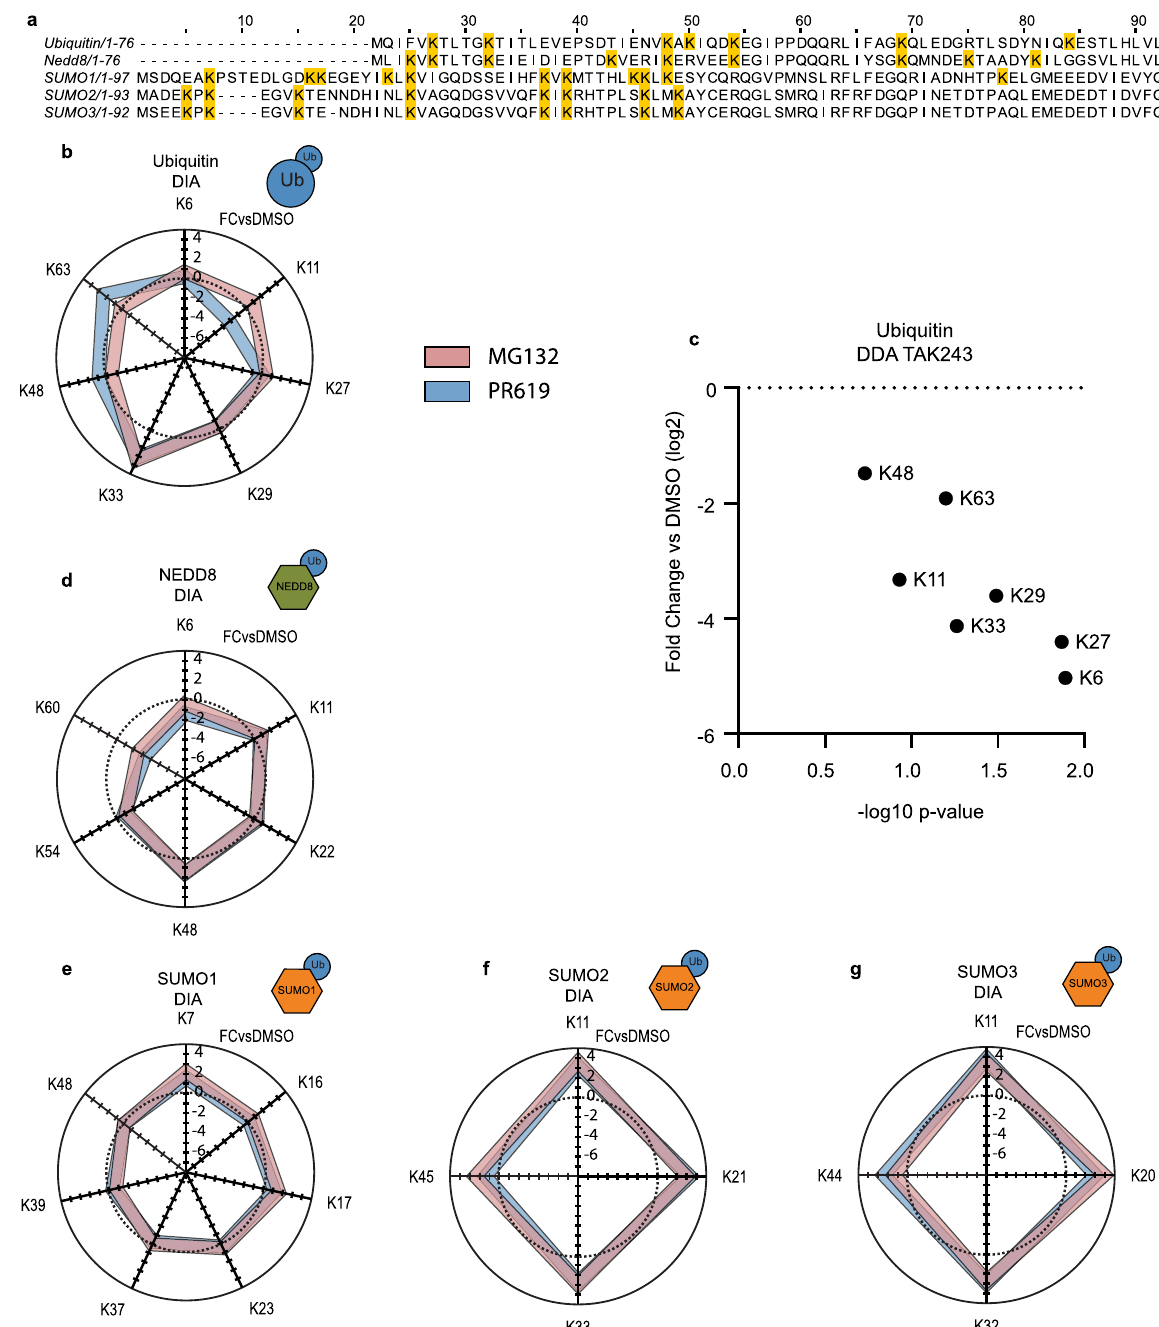
Fig. 6 Signalling dynamics of Ub polymers and Ub/Ubl heteropolymers. a Amino-acid sequence of Ub and other Ubls with internal lysines highlighted. b Radar plot of Ub sites identi fi ed using UbiSite DIA acquisition methodology, where each segment represents a lysine position (K) on Ub. Data are plotted as fold-change vs DMSO (log2) of indicated UPS inhibitor treatment at 3 h. The dotted line represents 0, n = 5. c diGly sites on Ub in UbiSite DDA data after 3 h TAK243 treatment, data are represented as log2 fold-change vs DMSO and − log10 p value (student ’ s t test, FDR = 0.05, S0 = 0.1), n = 3. d – g Additional radar plots with diGly sites identi fi ed on NEDD8 ( d ), SUMO1 ( e ), SUMO2 ( f ) and SUMO3 ( g ) in UbiSite DIA data, n = 5. Source data are provided as a Source Data fi